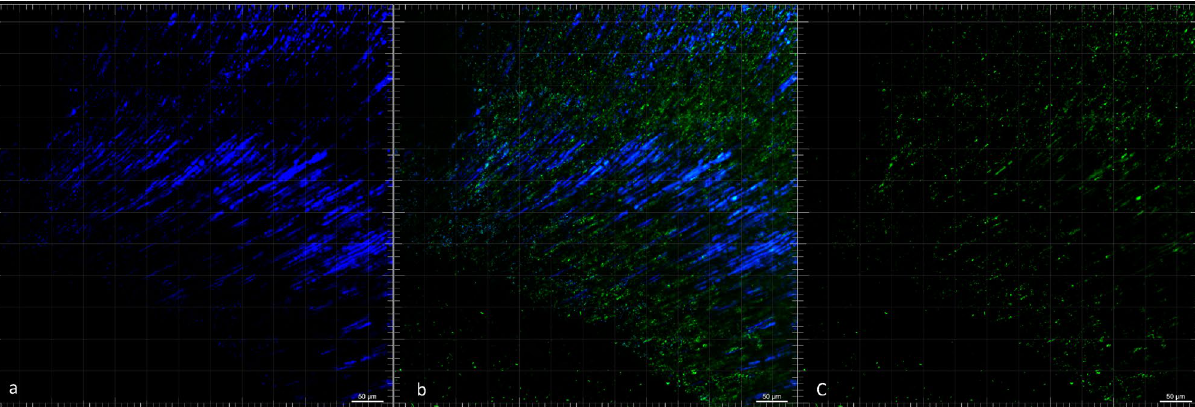
Figure 2. Representative CLSM image of the intraradicular infection with the dual-species biofilm model ( a ) E. faecalis cells in blue; ( b ) merged image; and ( c ) E. coli GFP (green fluorescent protein GFPmut3) cells in green. (20× Cervical third of the